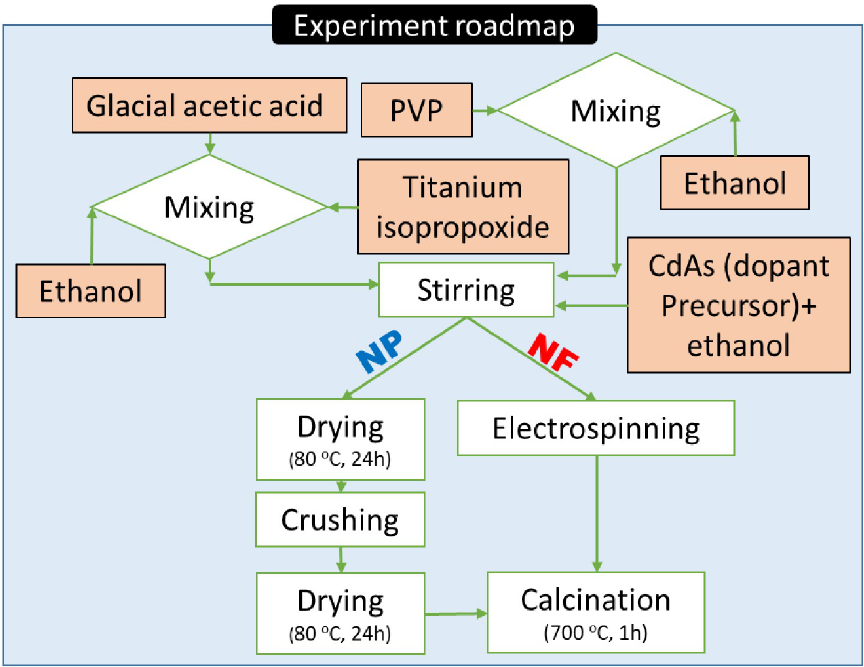
Fig 1. Experimental procedure for Cd-doped TiO 2 nanofibers and nanoparticles